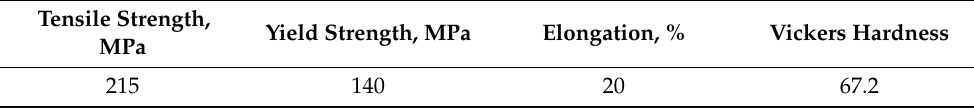
Table 2. Mechanical properties of